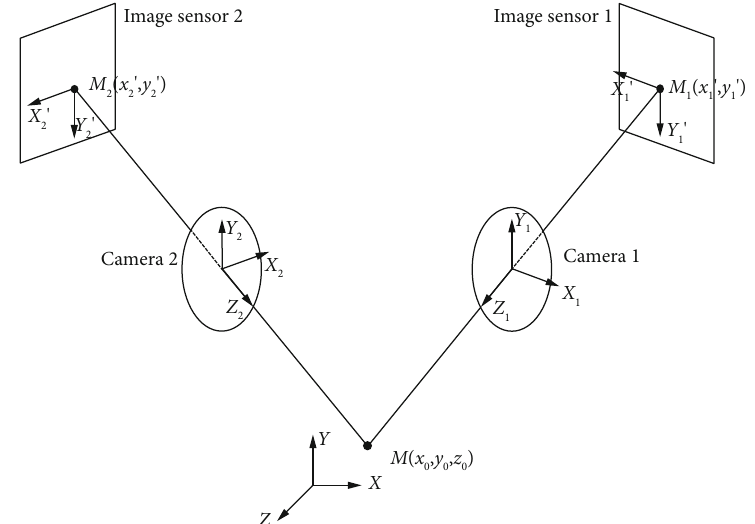
Figure 1: Schematic diagram of the DIC